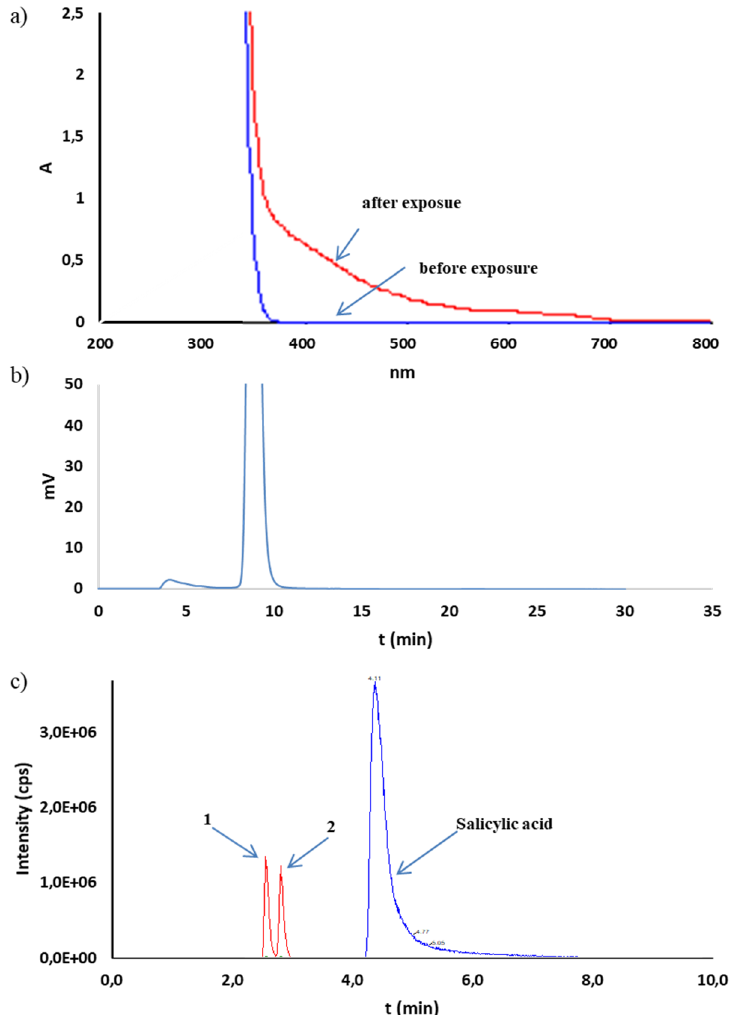
Figure 5. UV ( a ), HPLC-UV ( b ), and HPLC-MS / MS ( c ) analysis of CS solution (20 mg / mL) subjected to photodegradation (1.2 · 10 6 lux · h). 1—2,5-dihydroxybenzoic acid; 2—2,3-dihydroxybenzoic acid.